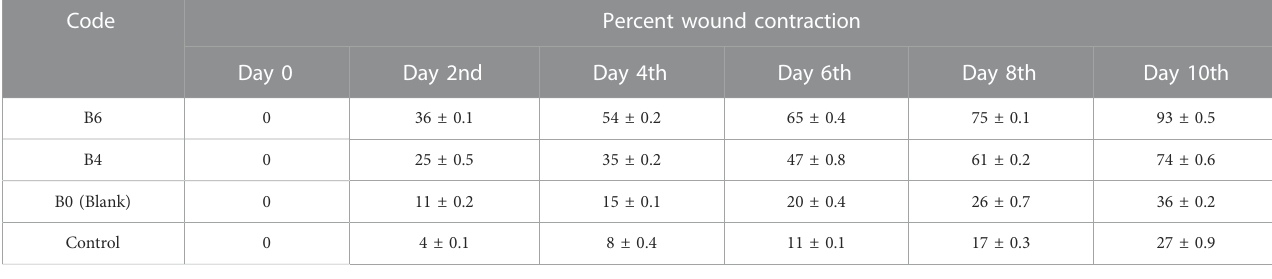
TABLE 4 % wound contraction of various formulations on different days (n = 4). Code